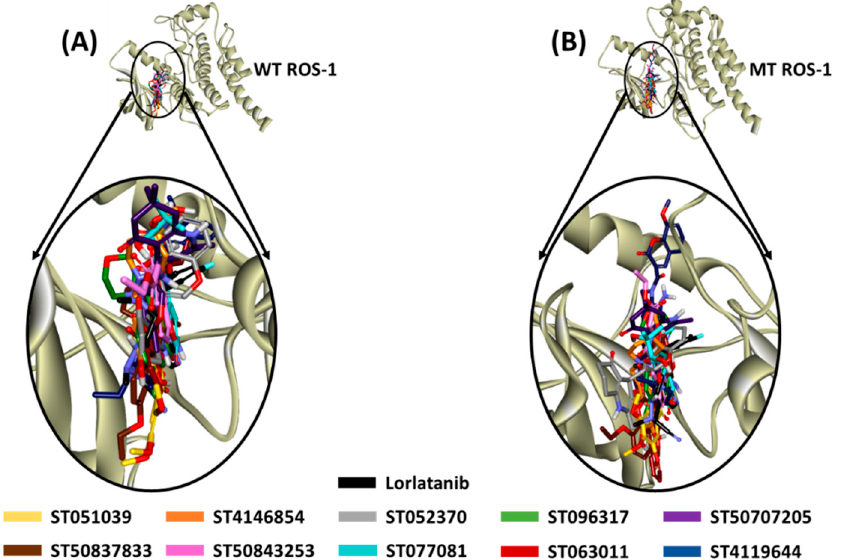
Figure 3. Backbone root-mean-square deviation (RMSD) analysis of ( A ) wild-type (WT) and ( B ) mutated (RT) ROS-1 systems.